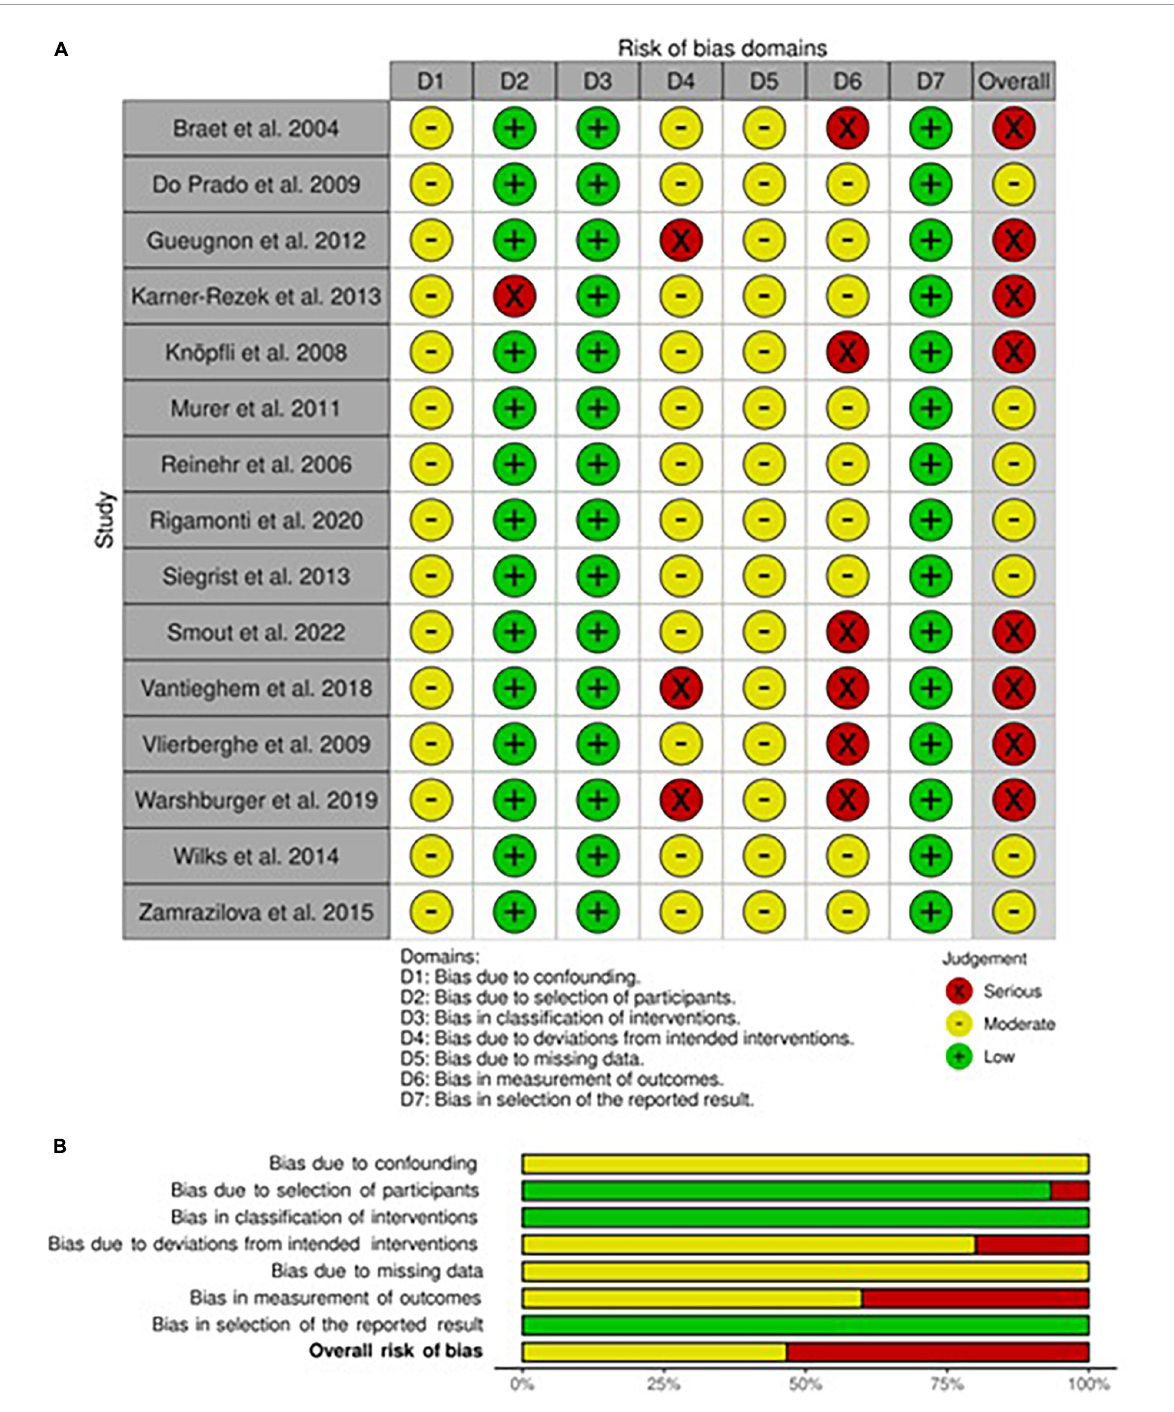
specify intensity level or diet without a precise indication of calories were judged at medium risk of deviation bias (25, 32, 35, 40). Missing data were also having some concerns in